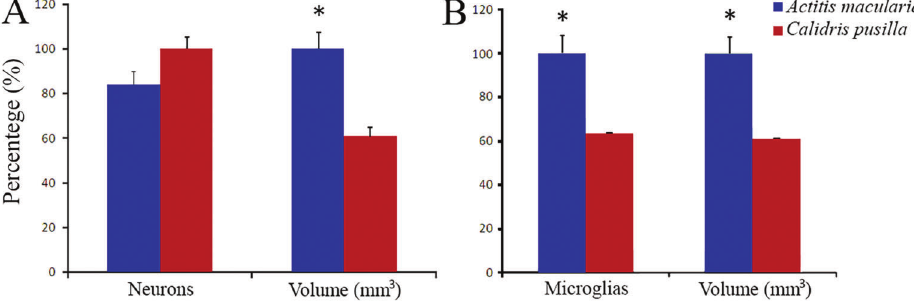
Figure 3. Neurons and microglia in the sandpiper hippocampus. A , Number of neurons and volume of the hippocampal formation reported as percentage values in Actitis macularia and Calidris pusilla (the highest value in each paired data set for the two species was assigned a value of 100%). For absolute numbers, see tables in Supplementary Material. Data are reported as means ± SE and asterisks indicate a statistically signi fi cant difference using Student ’ s t -test with P o 0.05. B , Number of microglia and volume of the hippocampal formation in A. macularia and C. pusilla . Data are reported as means ± SE and asterisks indicate a statistically signi fi cant difference using Student ’ s t -test with P o 0.05.